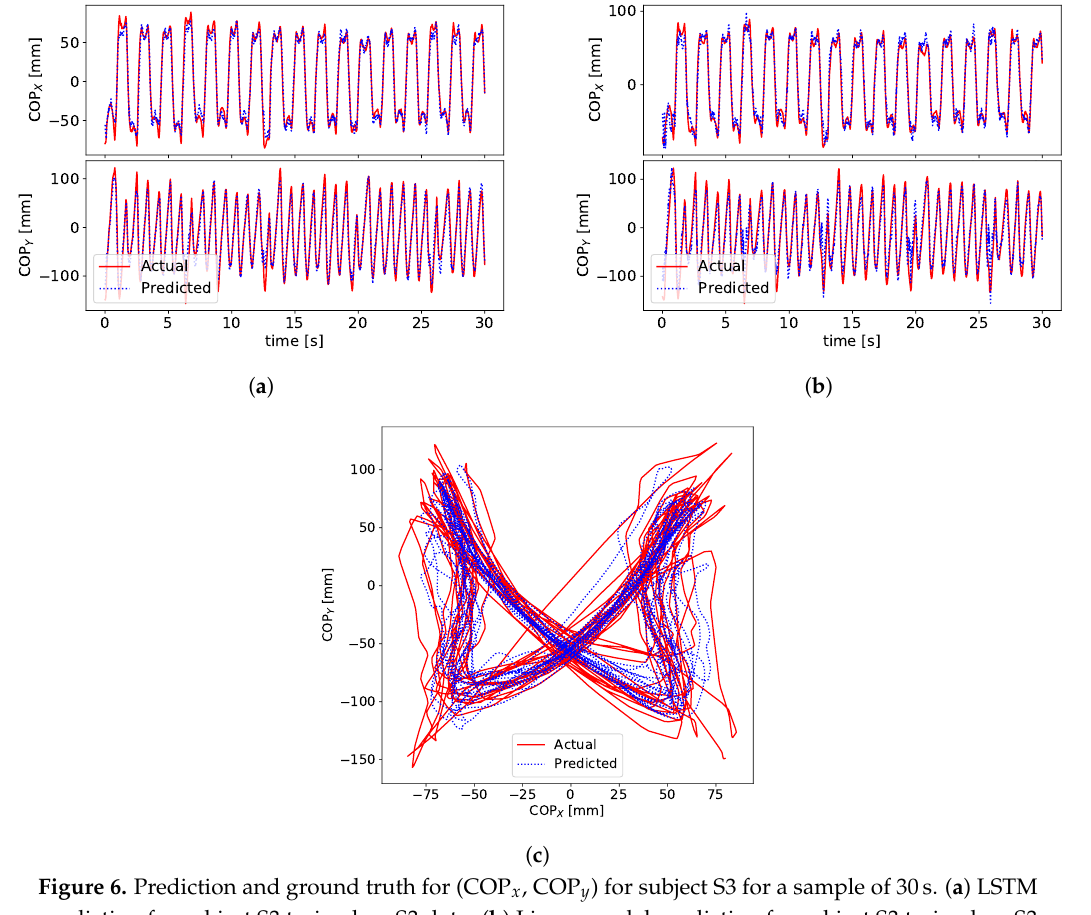
Figure 6. Prediction and ground truth for (COP x , COP y ) for subject S3 for a sample of 30 s. ( a ) LSTM prediction for subject S3 trained on S3 data. ( b ) Linear model prediction for subject S3 trained on S3 data. ( c ) LSTM prediction for subject S3 trained on S3 data.